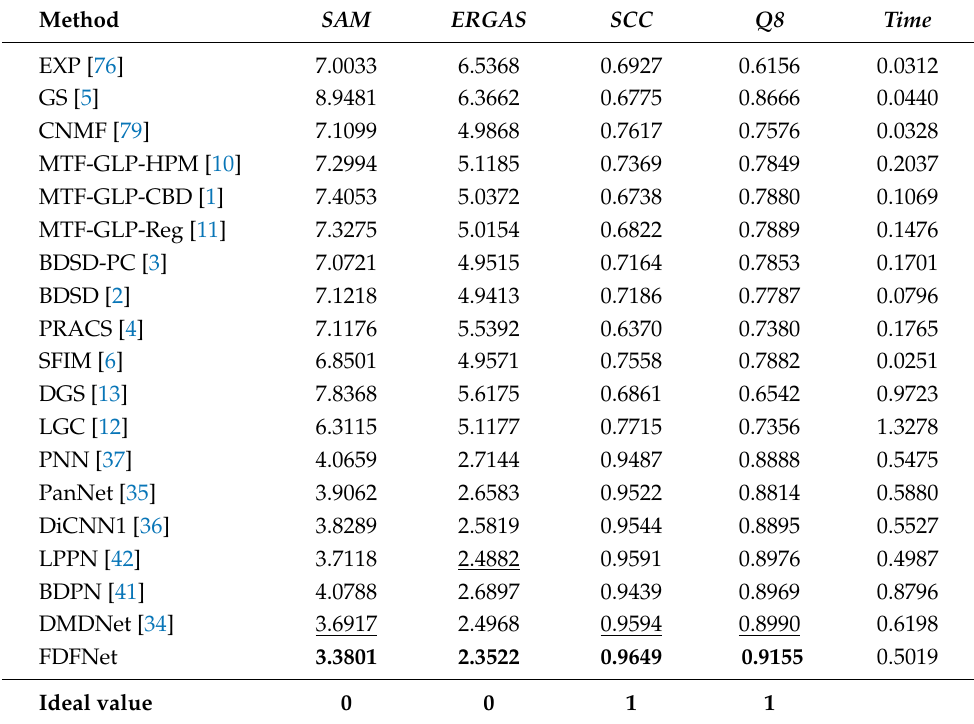
Table 2. Average quantitative comparisons on the Rio dataset. The best performance is shown in bold and second place is